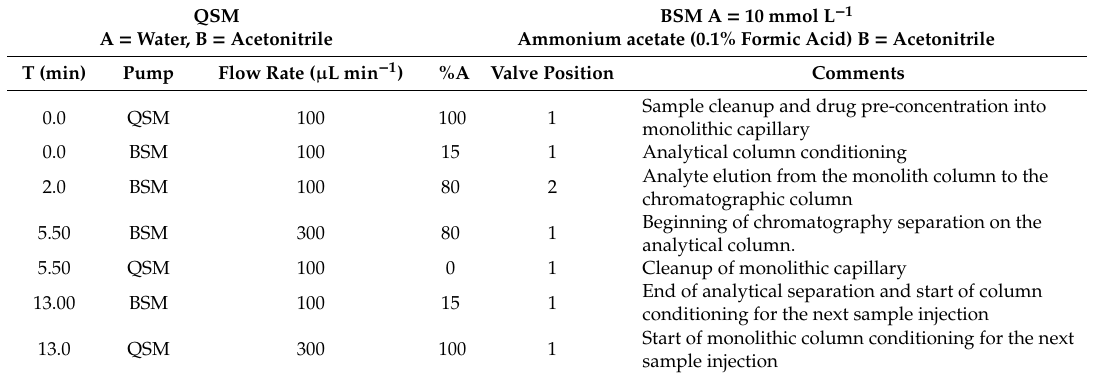
Table 7. Chromatography conditions for In-tube SPME-UHPLC-MS / MS analysis. QSM A = Water, B =